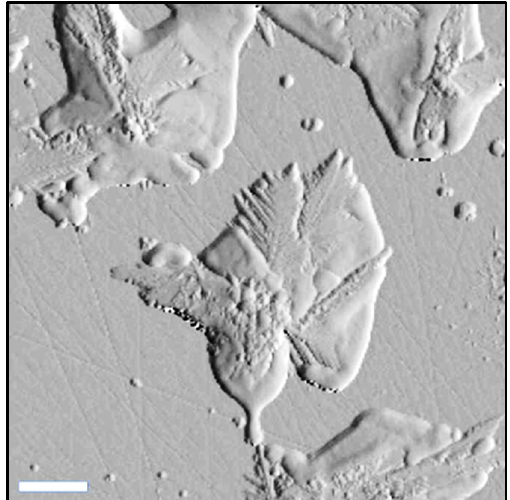
Figure 5. High resolution AFM topographical image of silver nanostars. The scale bar represents 2 µm.